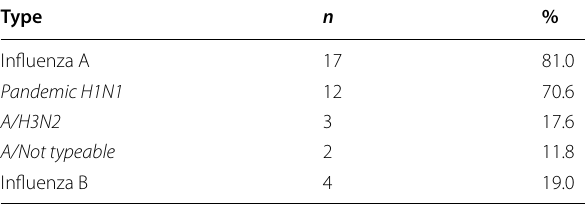
Table 4 Distribution of signs and symptoms and association with influenza Sign/symptom